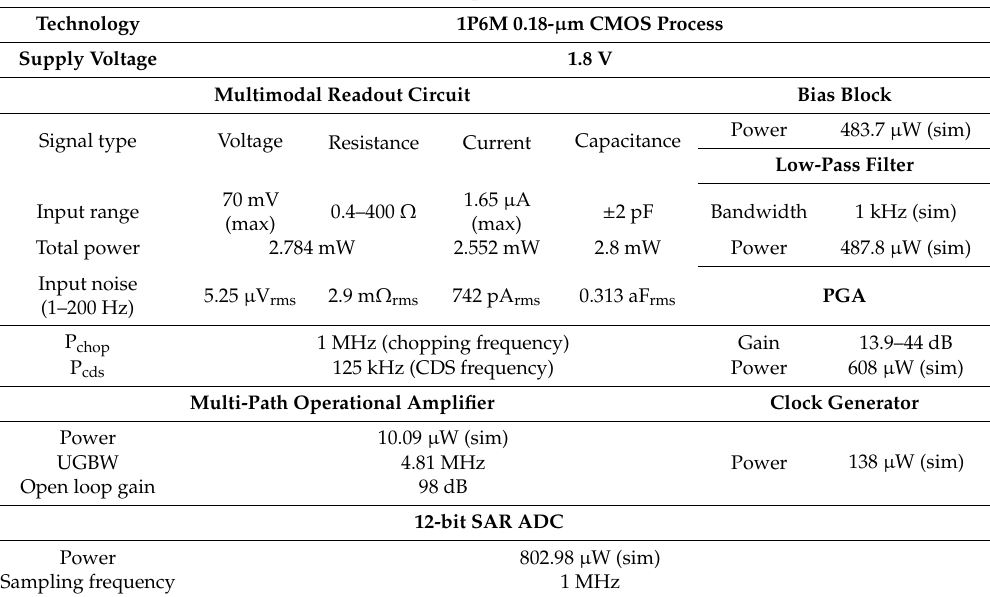
Figure 15. The measured offset voltage of the capacitive-sensing mode after adjustment. Table 1. Performance summary. CMOS: complementary metal-oxide semiconductor, UGBW: unit gain bandwidth.